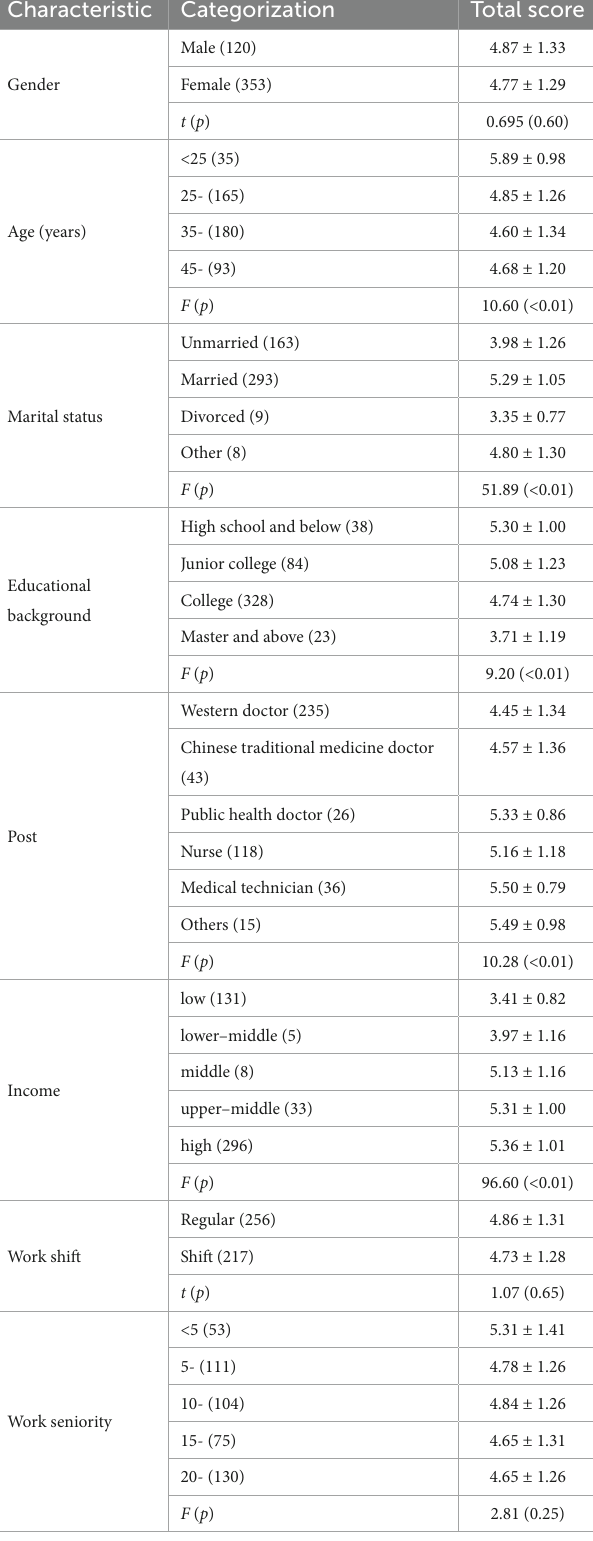
TABLE 3 Comparison of family doctors’ mean QWL scores on the questionnaire based on different demographic variables ( N = 473). Characteristic